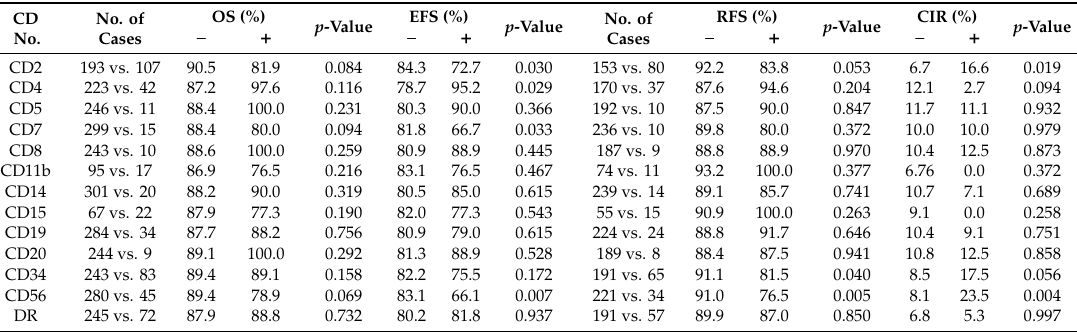
Table 4. CD phenotypes and clinical